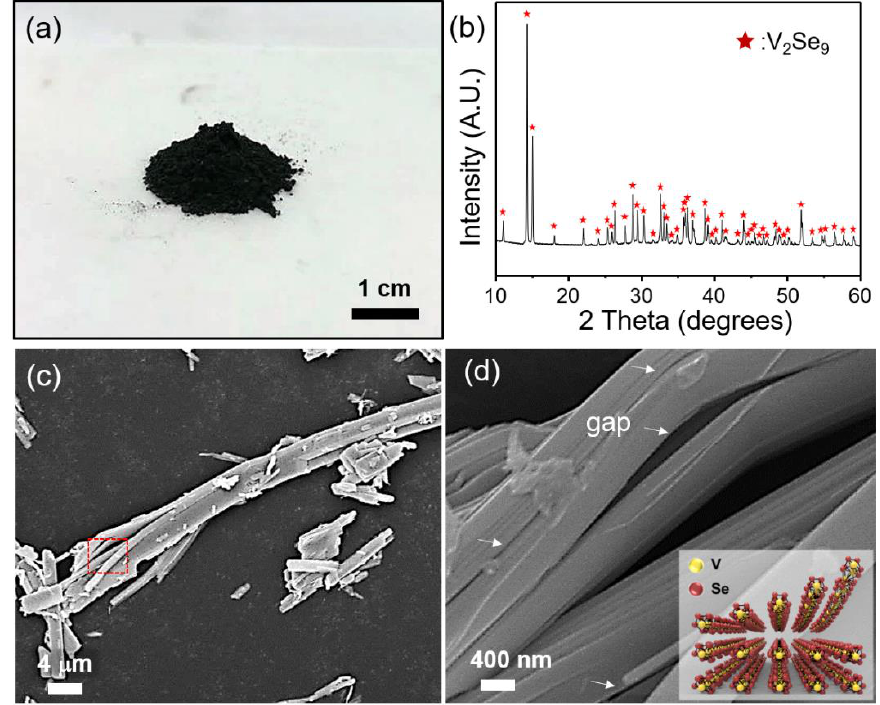
Figure 1. ( a ) Photo-image of mass production of V 2 Se 9 crystal. ( b ) XRD pattern of V 2 Se 9 crystal. ( c ) Low- and ( d ) high-magnification SEM images of V 2 Se 9 crystal. The inset shows an illustration of the crystal structure of V 2 Se 9 .